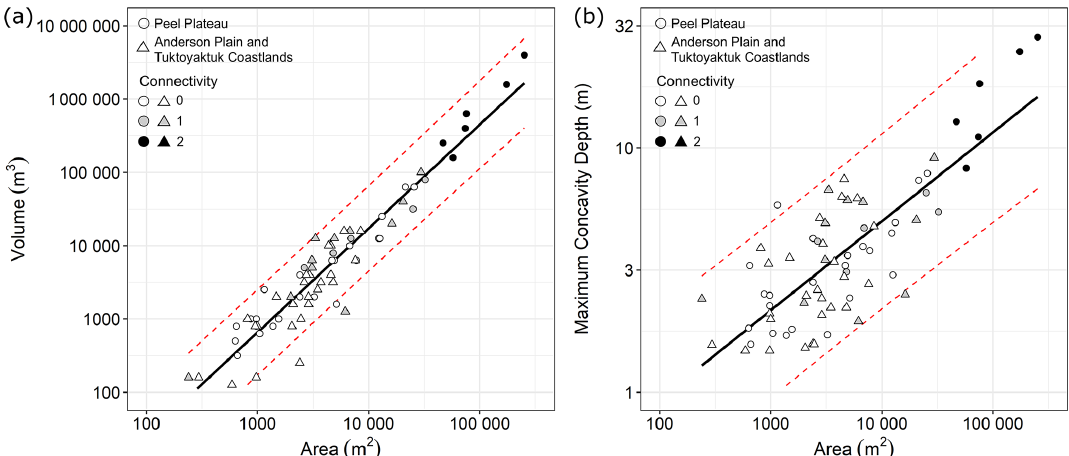
Figure 4. Relationships between (a) retrogressive thaw slump scar area and volume ( R 2 = 0 . 90; F = 641 . 9; N = 71; P < 0 . 0001) and between (b) retrogressive thaw slump scar area and maximum depth of concavity ( R 2 = 0 . 63; F = 116 . 2; N = 71; P < 0 . 0001) for distur- bances in the fluvially incised Peel Plateau and the lake-dominated Anderson Plain and Tuktoyaktuk Coastlands. Connectivity between the slope and downstream environment is categorized as follows: 0, no connectivity; 1, physical connection between the bare scar and down- stream environment; and 2, evidence of downstream deposition of materials into the valley, stream channel, or lake. The red dashed lines show the 95% confidence limit. Regression diagnostics indicate that residuals are normally distributed, and there are no unduly influential points.